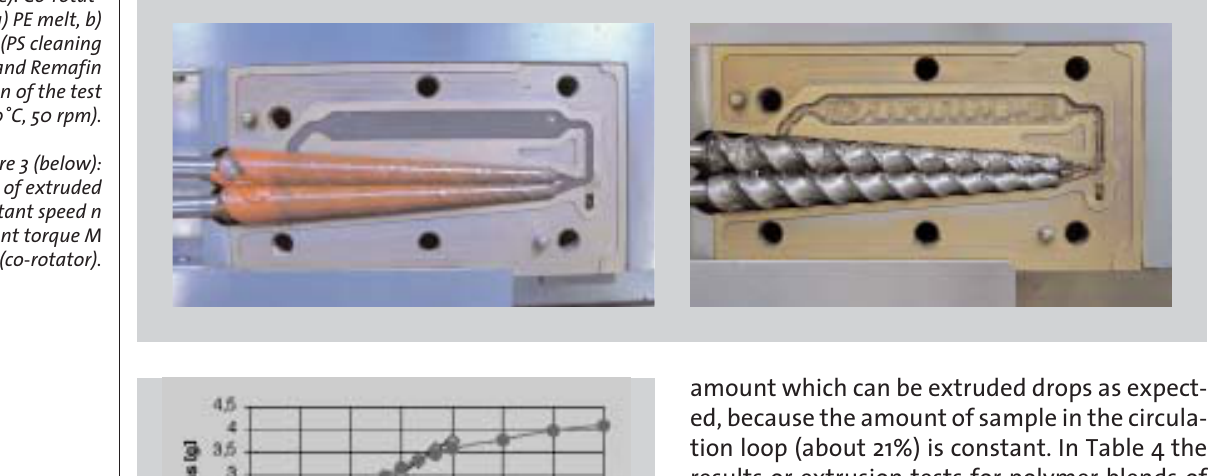
Figure 2 (above): Co-rotat- ing screws: a) PE melt, b) Asaclean (PS cleaning compound) and Remafin orange duration of the test t = 90 s (T = 220˚C, 50 rpm). Figure 3 (below): Comparison of extruded mass at constant speed n and at constant torque M (co-rotator).